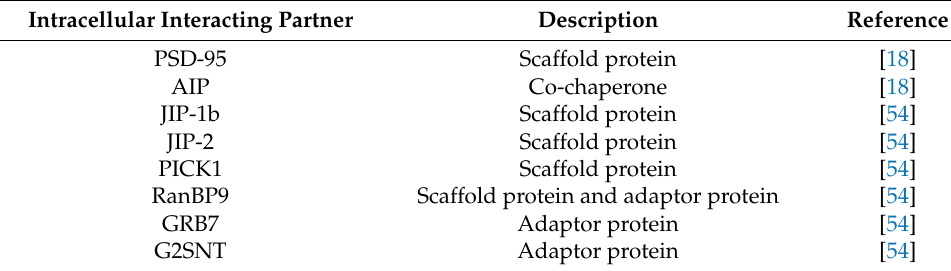
Table 2. Interacting partners of the intracellular domain of LRP1B.